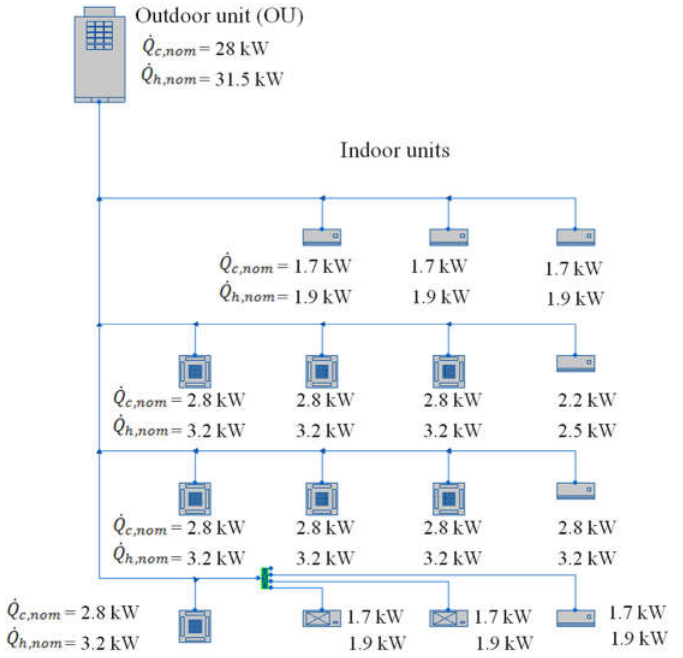
Figure 7. VRF Outdoor and Indoor Units.